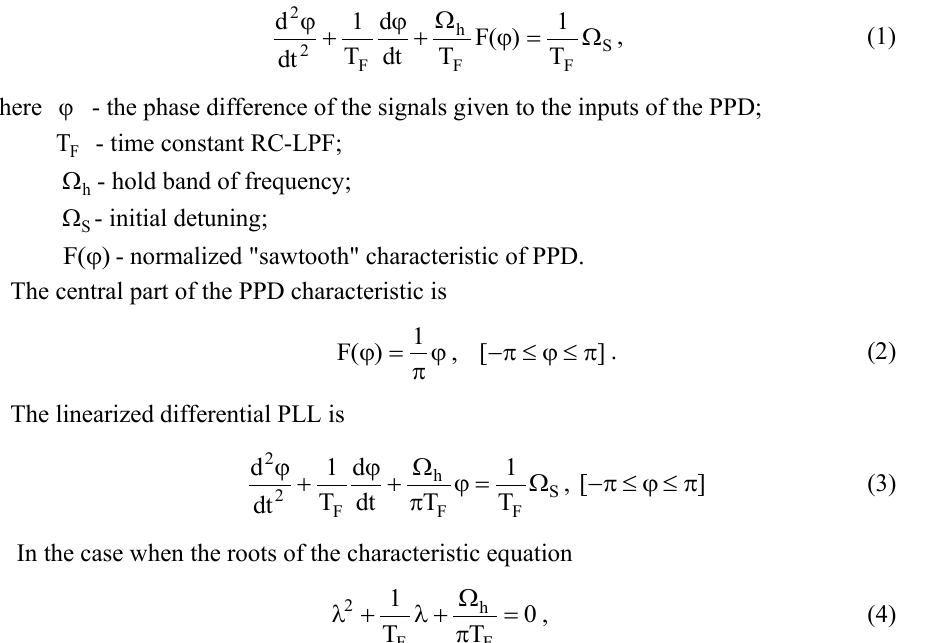
Fig. 1. Sustainable limit cycle (Limit cycle) and an invariant manifold O ( “stable focus” attractor 1